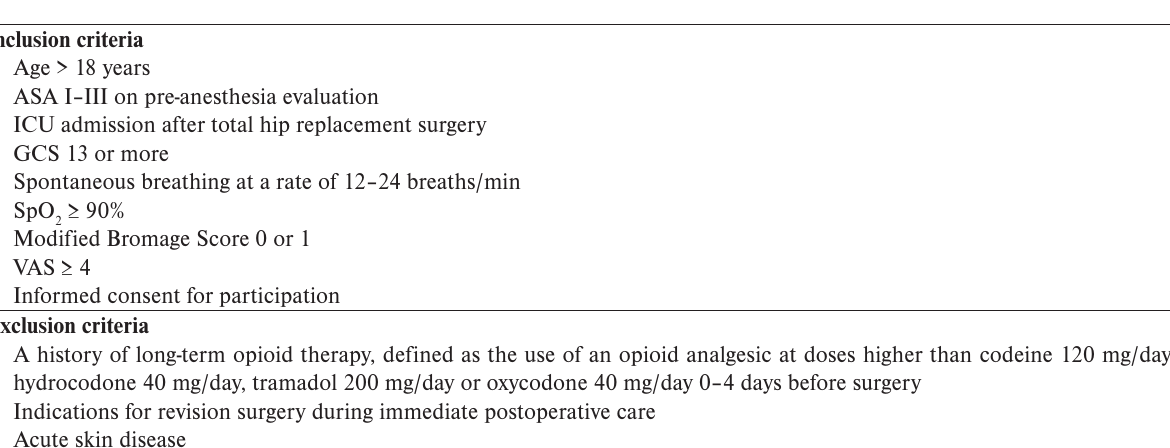
Table 1. Inclusion and exclusion